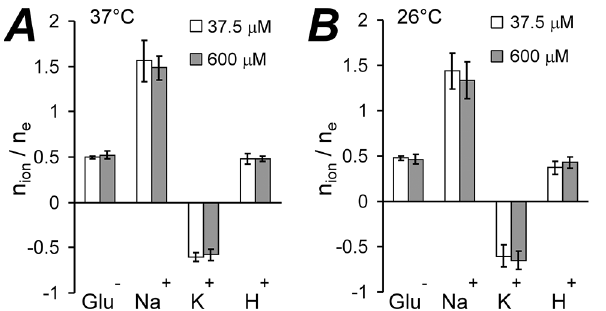
Fig 5. In the absence of chloride, GLT-1 glutamate transport stoichiometry remains constant at low and high glutamate concentrations, as well as at different temperatures. (A) GLT-1 transport stoichiometry at 37°C at low (open bars) and high (grey bars) glutamate concentrations. For pair of transported elementary charges GT1 co-transports approximately one glutamate, three sodium ions, and one proton, and counter-transports one potassium ion. (B) GLT-1 transport stoichiometry at 26°C at low (open bars) and high (grey bars) glutamate concentrations. The stoichiometry is the same as at 37°C and approximately has the following transport ratios: n Glu- /n e+ = ½ , n Na+ /n e+ = 3/2, n K+ /n e+ = - ½ , and n H+ /n e+ = ½ .